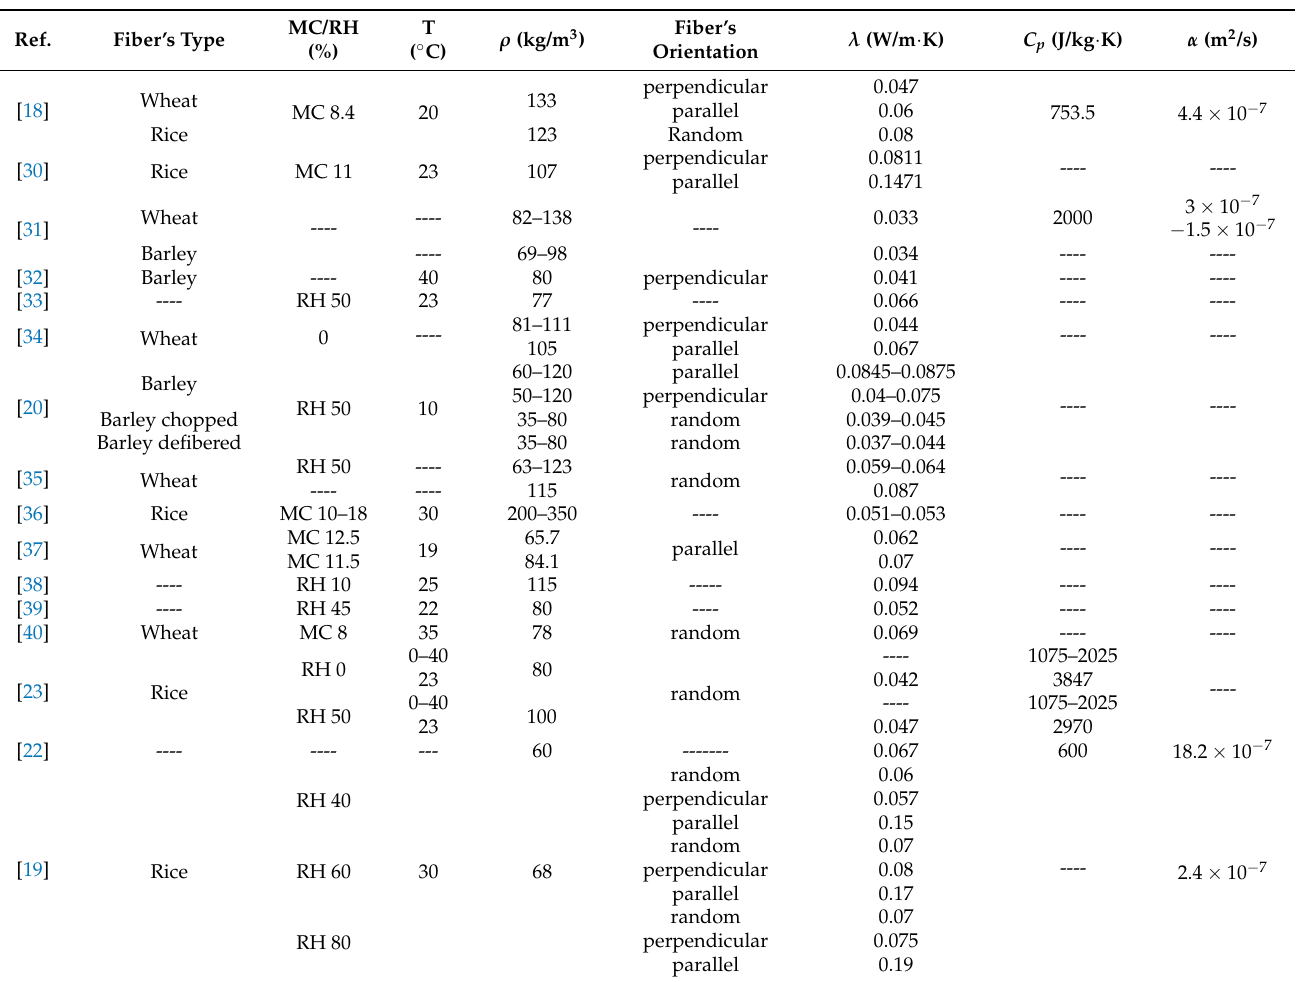
Table 1. Straw bale thermal conductivity ( λ ), heat capacity ( C p ) and thermal diffusivity ( α ) versus density ( ρ ), moisture content ( MC ) or relative humidity ( RH ), temperature ( T ), and the fiber’s type and